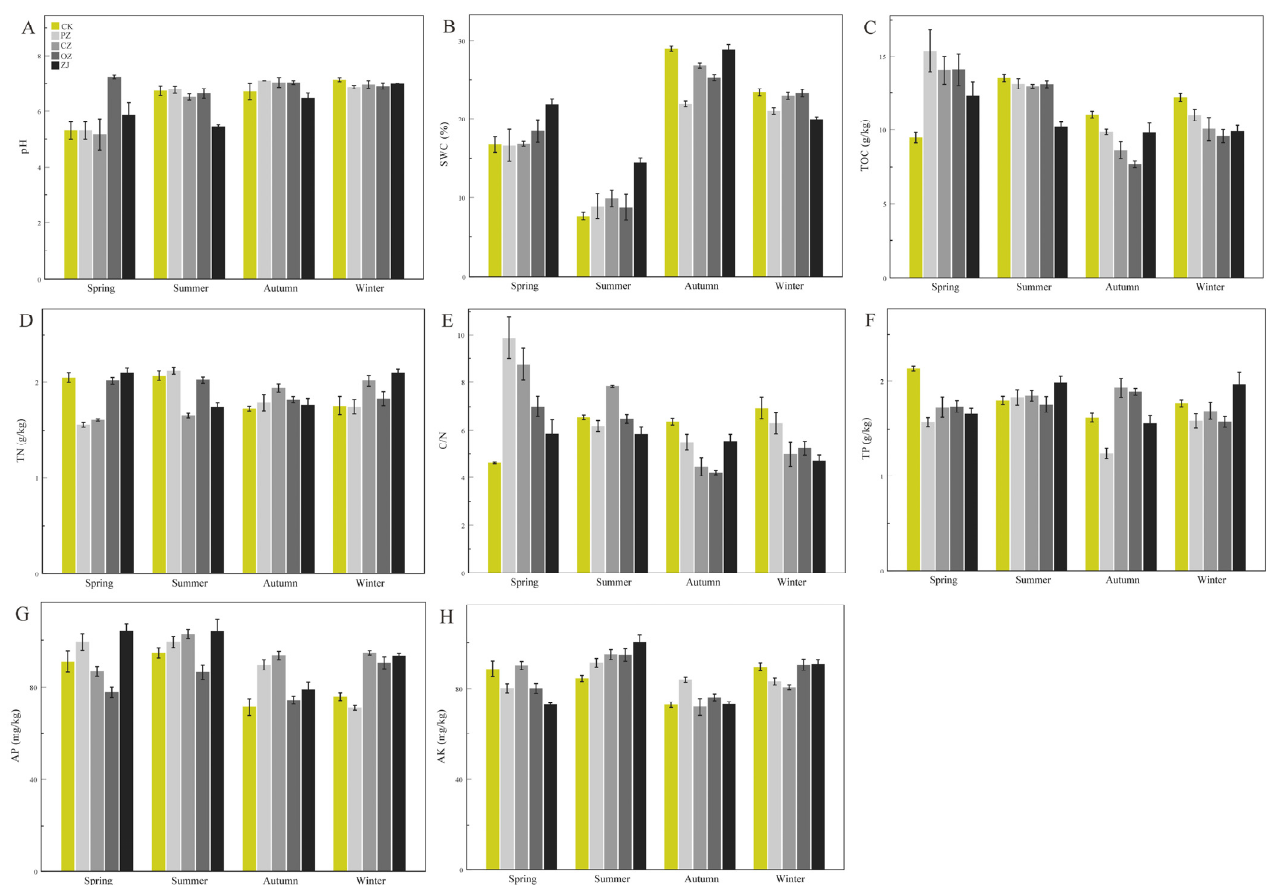
Figure 1. Soil physicochemical properties of four species of the genus Corylus across different seasons. ( A ) pH; ( B ) SWC; ( C ) TOC content; ( D ) TN content; ( E ) C/N content; ( F ) TP content; ( G ) AP content; ( H ) AK content. SWC: soil water content; TOC: total organic carbon; TN: total nitrogen; C/N: ratio of C and N; TP: total phosphorus; AP: available phosphorus; AK: available potassium; CK: control; PZ: C . heterophylla ; CZ: C . kweichowensis ; OZ: C . avellane ; ZJ: C . heterophylla × C . avellane .